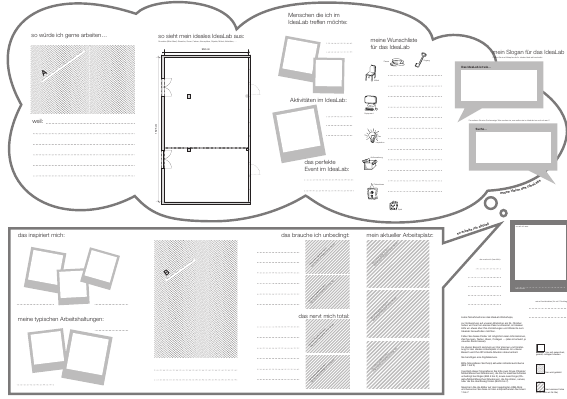
Fig. 3. Visual canvas used (1) for individual self- documentation and reflection prior to the workshop and (2) for co-creating ideas during the workshop.